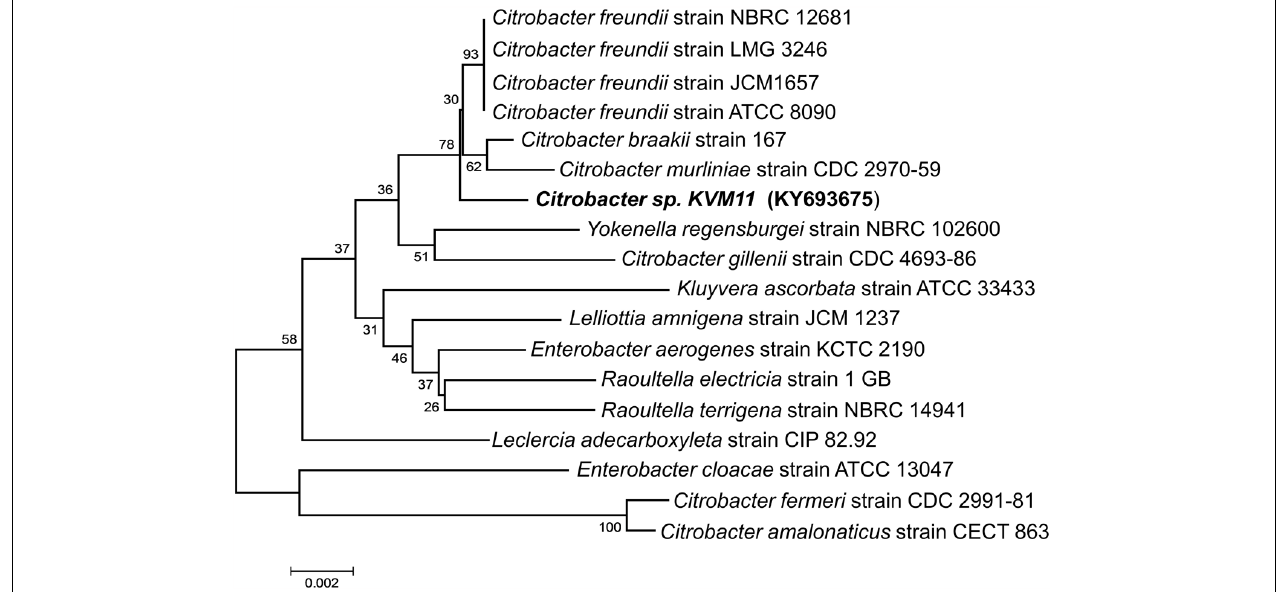
FIGURE 2 | Phylogenetic tree based on 16S rRNA gene sequences showing the positions of the isolated Citrobacter sp. KVM11 and closest representatives of other Citrobacter sp. The sequences of Citrobacter farmeri and C. amalonaticus formed an outgroup sequence. The tree was constructed from 1,418 aligned bases using the neighbor-joining method. The number at nodes show the percentages of occurrence of the branching order in thousand bootstrapped trees. Scale bar represents 0.005 substitution per nucleotide position.